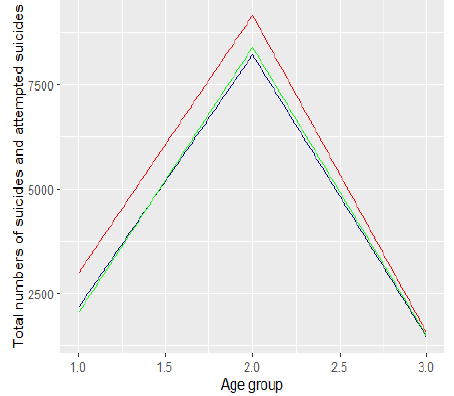
Figure 2. Absolute number of suicide attempts in Poland between 2019 and 2021.